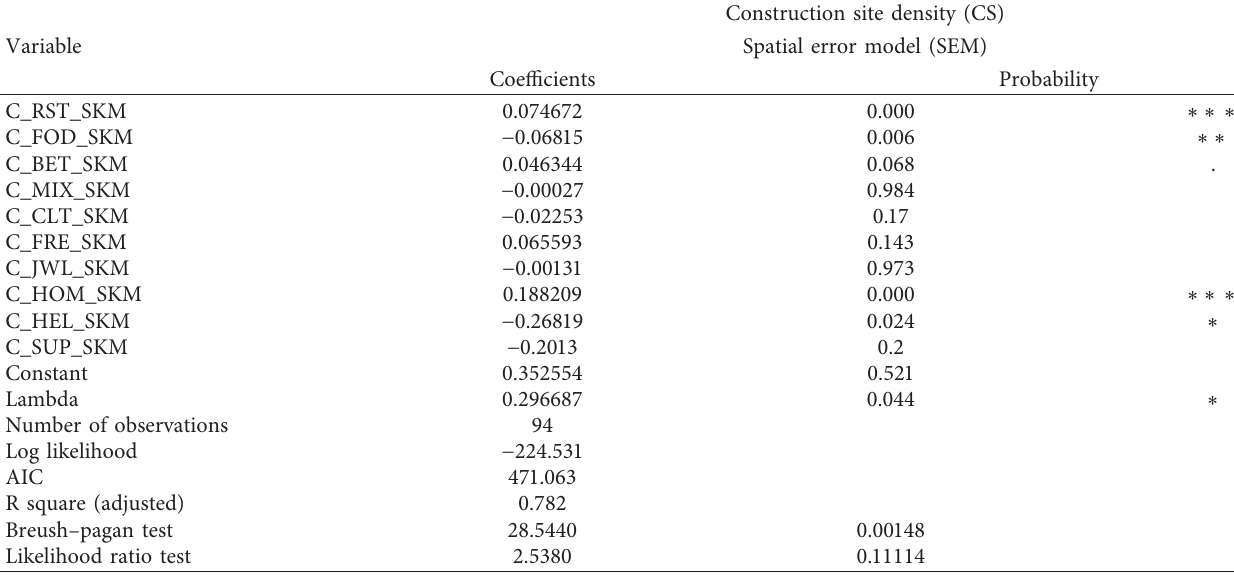
Table 7: SER model to assess the relationship between the CDS and different typologies of the retail activities (source: authors’ elaboration). Variable